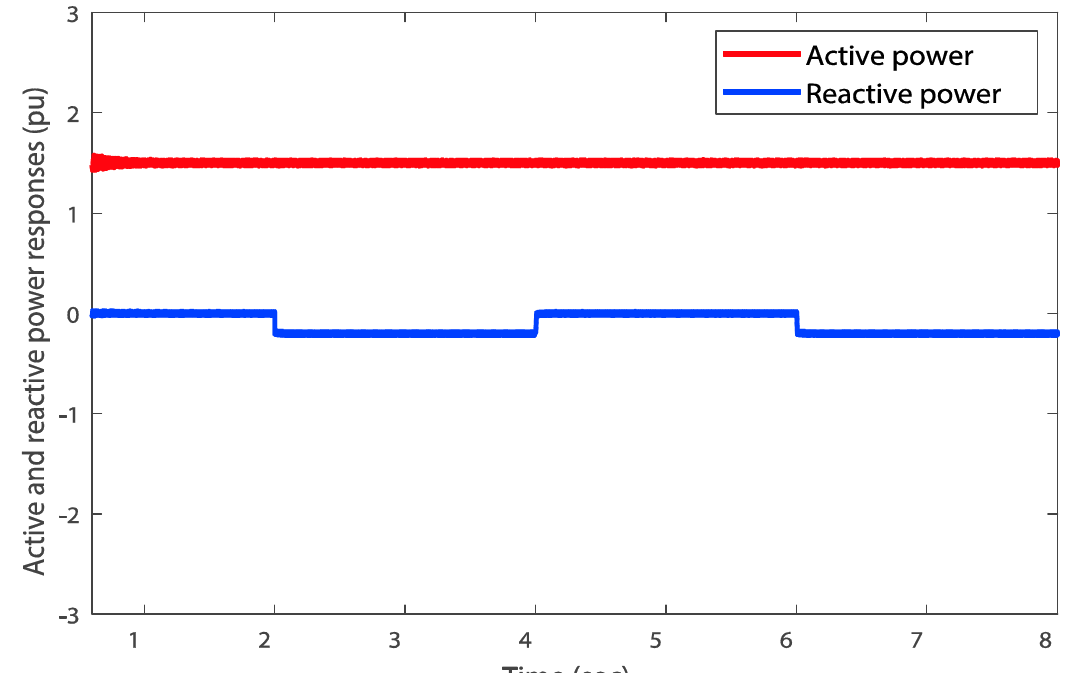
Figure 13. Time-domain variations of the TEO-tuned PI controlled active and reactive powers. Math. Comput. Appl. 2019 , 24 , x FOR PEER REVIEW